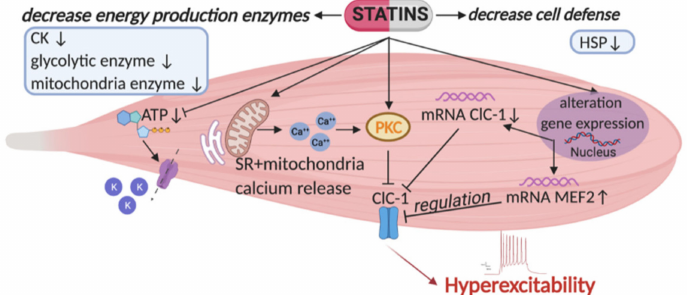
Figure 1. Representation of the major risk factors causing skeletal muscle impairment as found in statin-treated animal model [46,50]. Statins affect the activity and expression of ClC-1 chloride channel, a protein typically present in skeletal muscle and important for its function. Indeed, this channel controls sarcolemma excitability by stabilizing the resting potential, and preventing repetitive runs of discharges after the action potential. As shown, statins reduce ClC-1 gene and protein expression and increase that of the protein kinase C (PKC), which is known to induce phosphorylation and closure of the channel. PKC activation is also sustained by an enhancement of calcium release from the sarcoplasmic reticulum (SR) and mitochondria. This mechanism produces a decrease of resting chloride conductance (gCl), maintained by the ClC-1 channel, leading to a persistent hyperexcitability. It is likely that the modification of ClC-1 can be due to the observed increase of MEF2 (related to PKC activation and found to be increased during myotonia). Moreover, statin by reducing cholesterol, reduces coenzyme Q (CoQ) and ATP level. This reduction, together with reduction of glycolytic and mitochondrial enzymes, can be detrimental for skeletal muscle function. In addition, ATP reduction leads to the opening of ATP-sensitive potassium channels (KATP) as a compensative mechanism. This is complicated by a decrease of proteins responsible for cellular defenses against oxidative stress, for instance the heat shock proteins (HSP). All these new pharmacological targets may be attractive in the control of statin induced side effects in skeletal muscle. Arrows up and arrows down indicate an increase and a decrease,